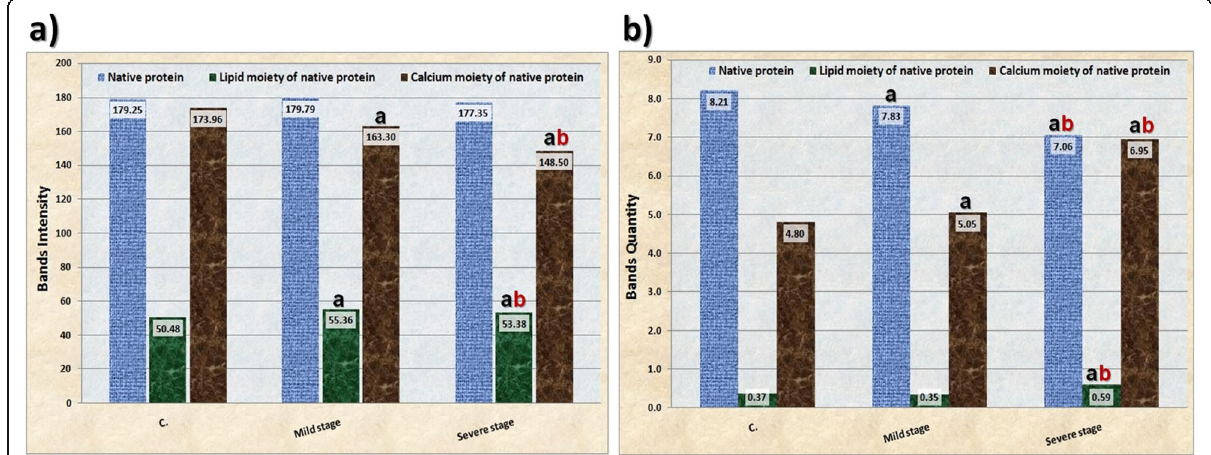
Fig. 2 Statistical comparison showing the differences in a ) Intensities and b ) Quantities of the total bands of electrophoretic native protein, lipid and calcium moieties of native proteins in asthmatic bronchitis patients at mild and severe stages as compared to control (healthy individuals). a Significant difference as